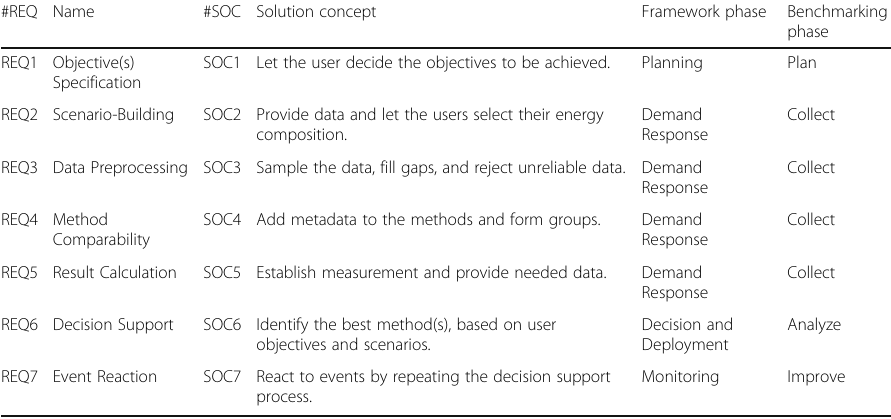
Table 3 Derived REQs and SOCs